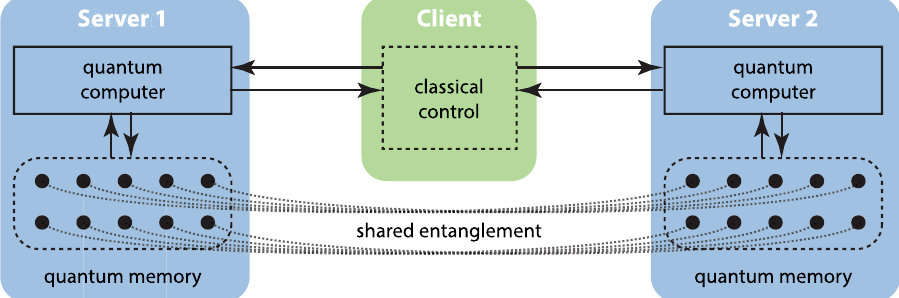
Fig. 7 The scenario considered by current multi-server protocols. The client communicates classically with two or more servers. The servers are prohibited from communicating with each other directly, but are required to share a large number of entangled